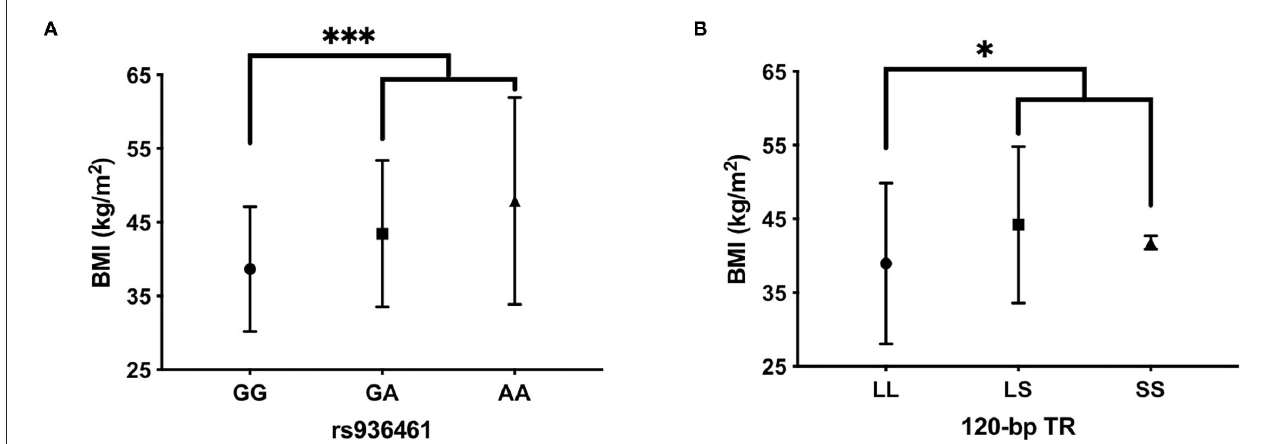
FIGURE 2 | Evaluation of body mass index (BMI) among carriers of DRD4 - rs936461 GG, GA, and AA genotypes (A) and DRD4 -120bp TR LL, LS, and SS genotypes (B) in BED patients. Statistical comparisons were performed by one-way ANOVA with post-hoc correction by the Tukey method. *** p < 0.001 vs. carriers of